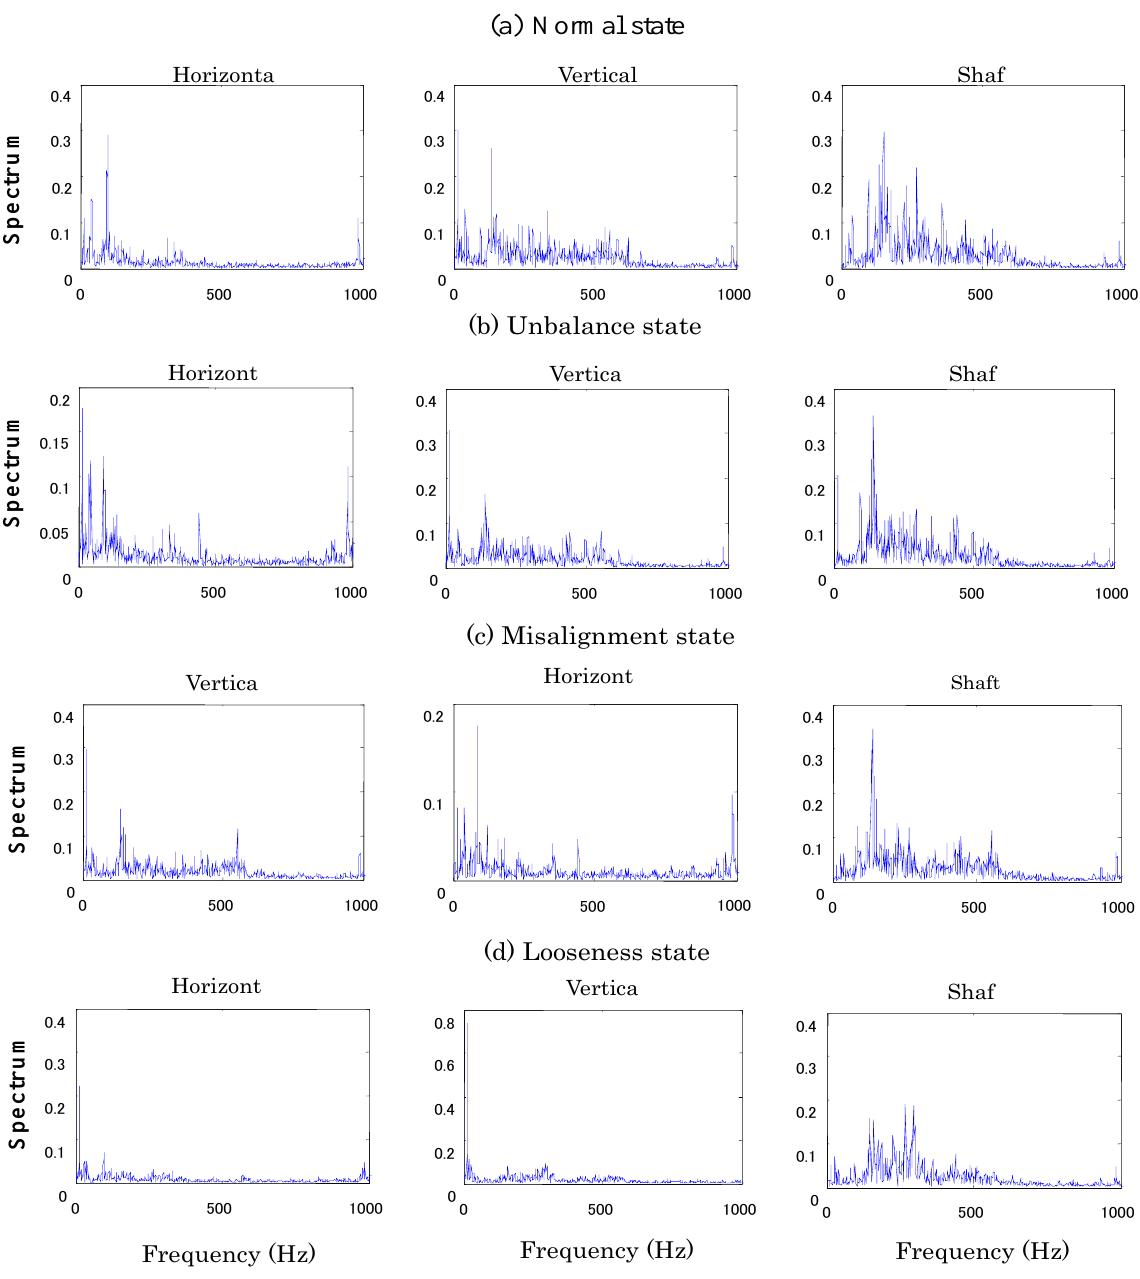
Figure 6. Raw vibration signals in frequency domain. (a) Normal state, (b) Unbalance state, (c) Misalignment state, (d) Looseness